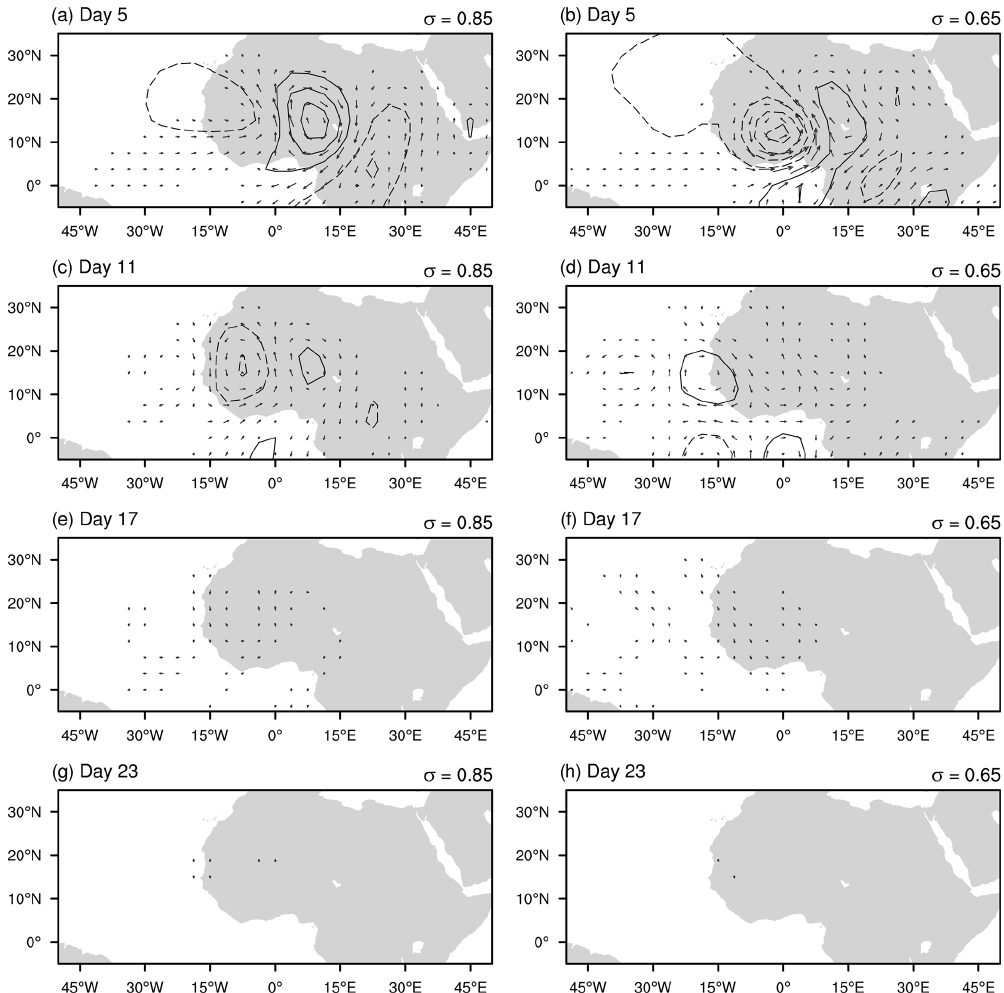
Figure 7. Streamfunction (interval 1 × 10 5 m 2 s − 1 with negative values dashed) and horizontal wind vectors at σ = 0 . 85 (a, c, e, g) and 0.65 (b, d, f, h) showing the wave response within the short-lived basic state for days 5, 11, 17, and 23 from top to